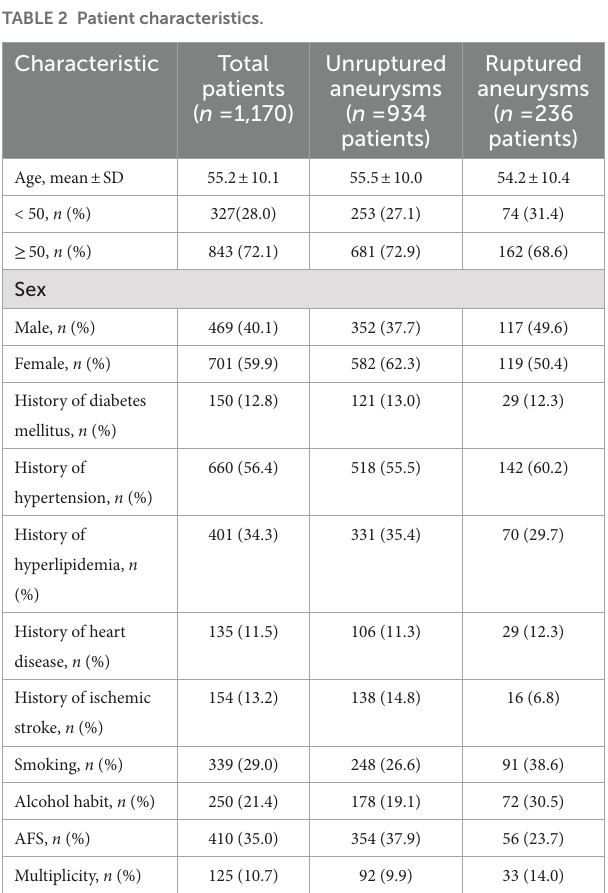
TABLE 2 Patient characteristics.